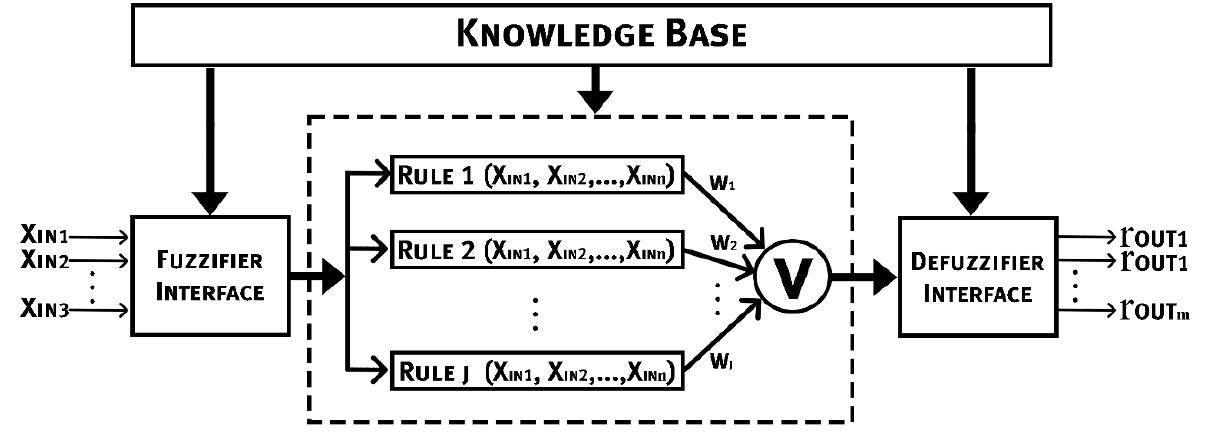
Figure 3. Fuzzy logic method flowchart used in this study modified from [34].